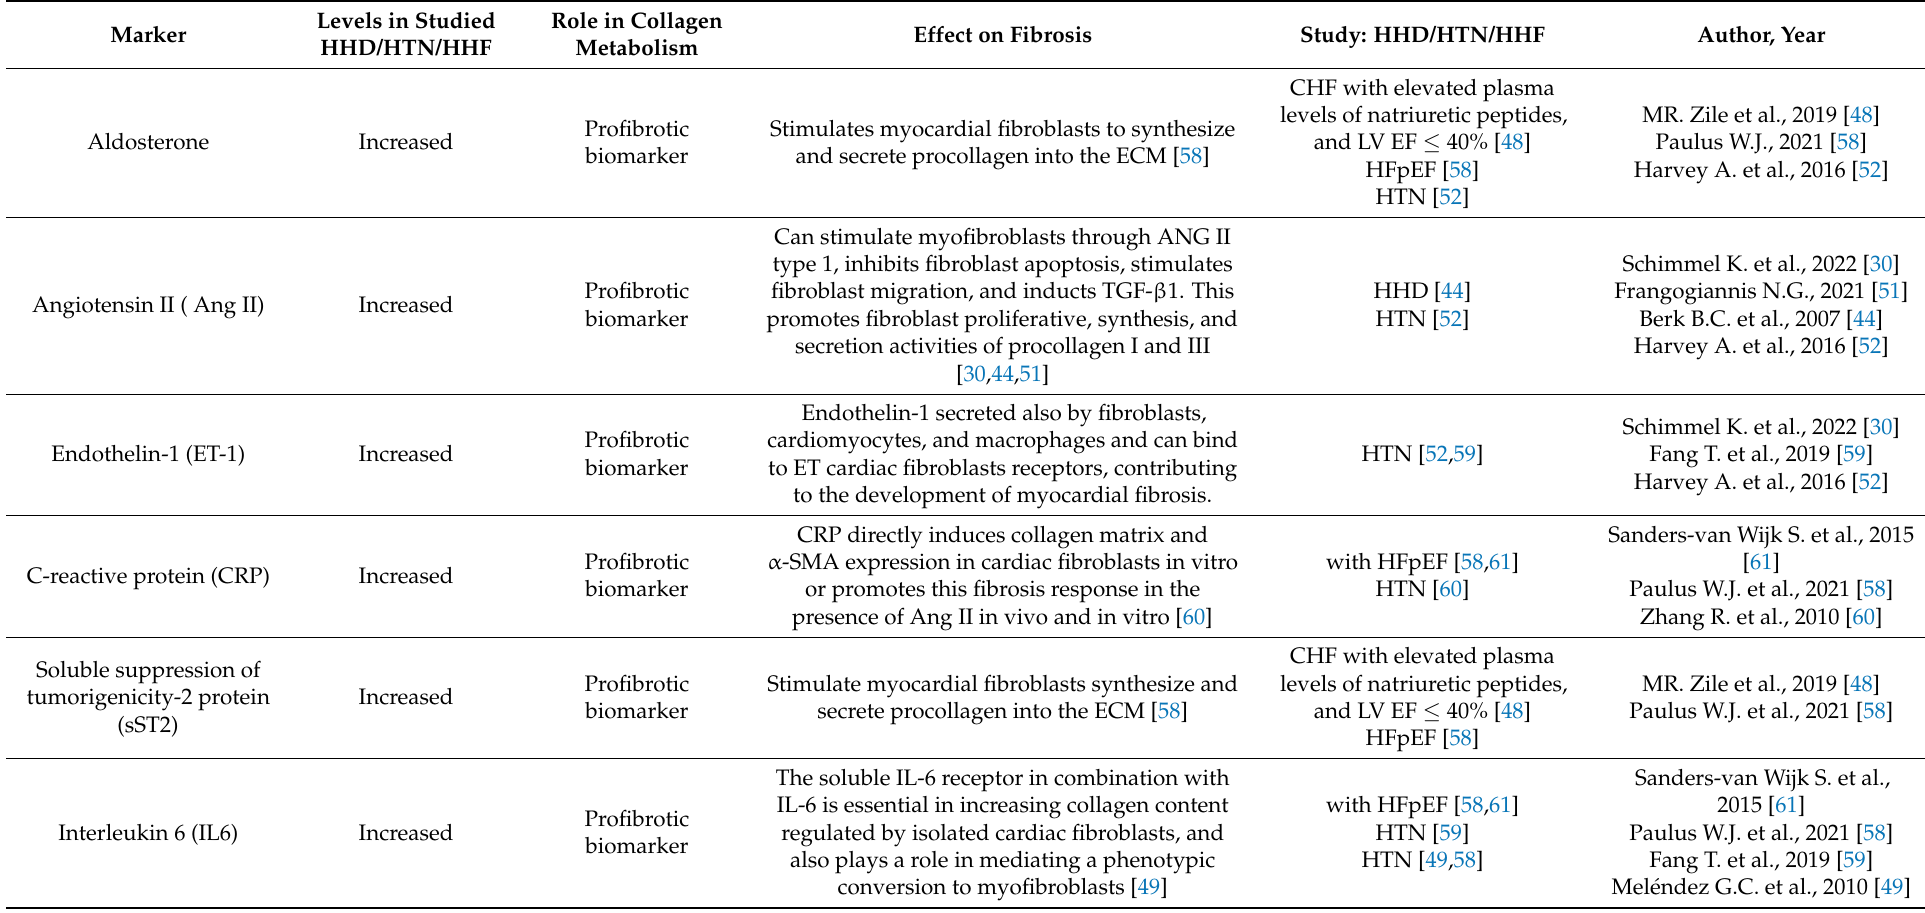
Table 2. Selection of circulating biomarkers that reflect mechanisms of extracellular matrix remodeling and vascular fibrosis, and their possible